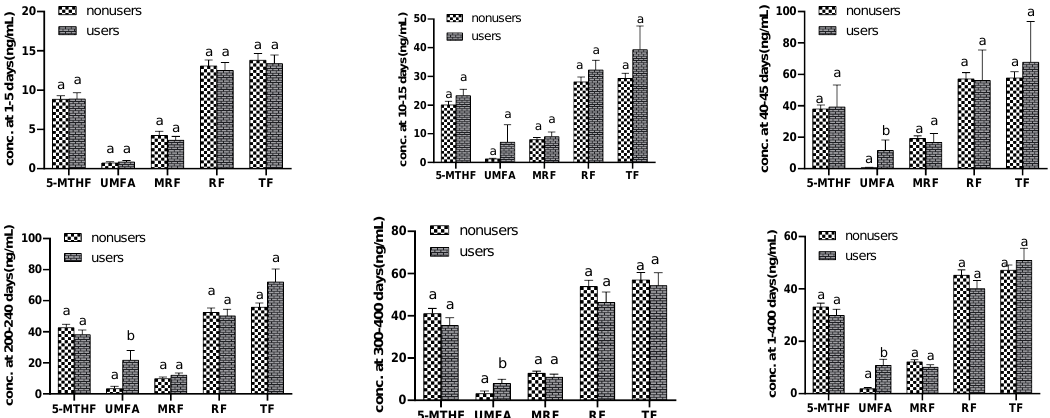
Figure 2. Mean ± SE 5-MTHF, UMFA, minor reduced folate (MRF), reduced folate (RF) and total folate (TF) contents in the breast milk of Chinese women, in women who were folic acid-supplement nonusers and users at 1–5 day, 10–15 day, 40–45 days, 200–240 day, 300–400 days and 1–400 days postpartum, respectively. Note: p values (2-sided) were derived by using the two-independent nonparametric test (Kolmogorov – Smirnov Z). Values that do not share a lowercase letter are significantly different; p < 0.05 was considered significant.